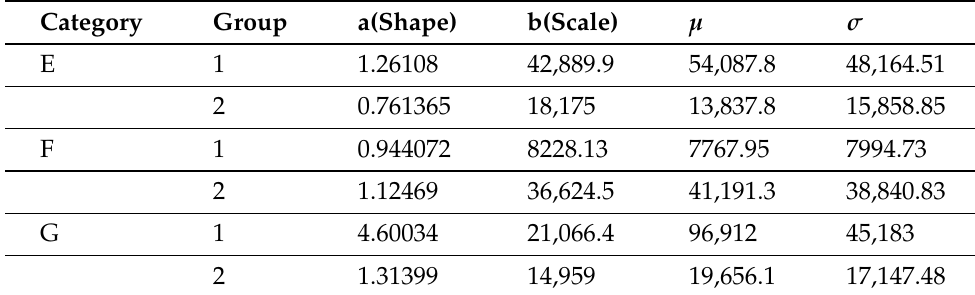
Table 15. Parameters estimation for Categories E, F and G.